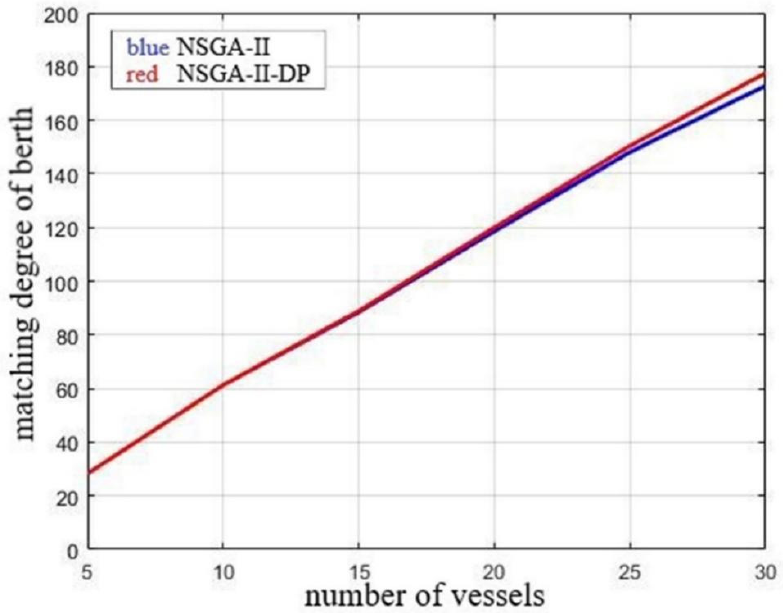
Figure 15. The average value of the optimal value of the berth matching degree over 10 calculations.